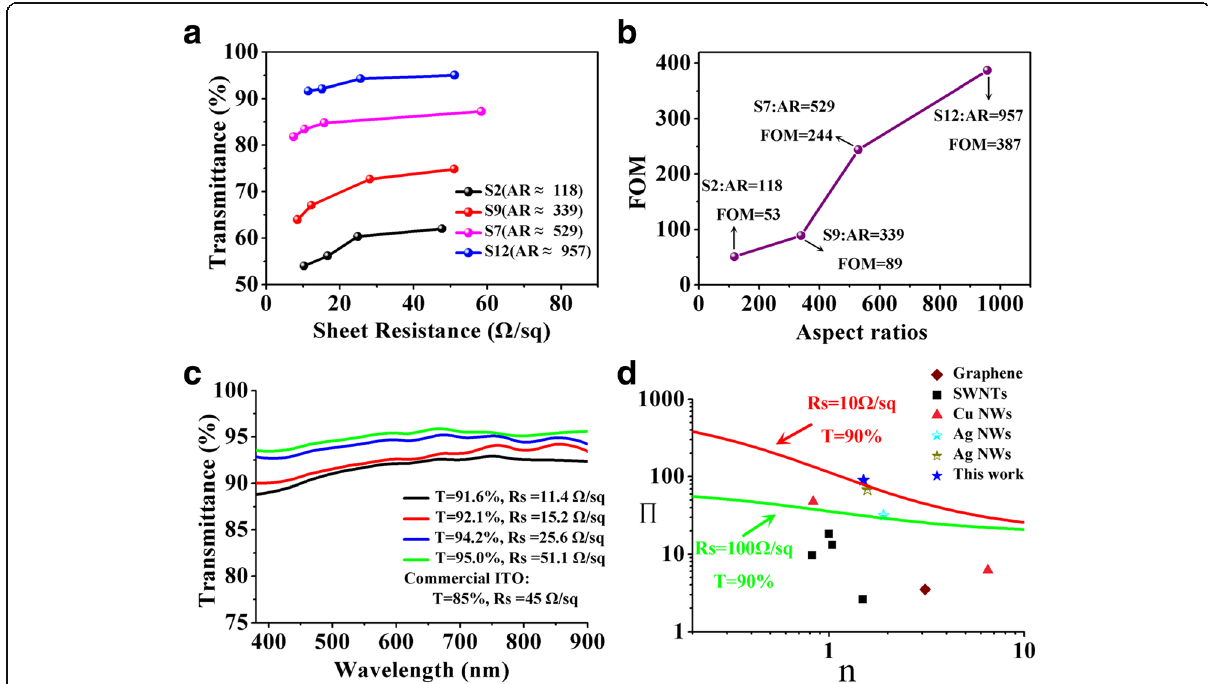
Fig. 6 a Comparison of optoelectronic performance of NTEs fabricated by Ag NWs with different aspect ratios (AR). b The best FOM values of Ag NWs films vs the AR of Ag NWs. c The optical transmittance spectra of Ag NWs films fabricated from sample S12. d Percolative figure of merit ( П ), plotted against conductivity exponents ( n ). The solid lines are plotted at the given combinations of transmittance ( T ) and sheet resistance ( R s ), as calculated from eq. (3). The plotted data of graphene, SWNTs, Cu NWs, Ag NWs are from recently published reports [37, 67, 81]. The star symbol represents the results of Ag NWs films fabricated using sample S12 from this